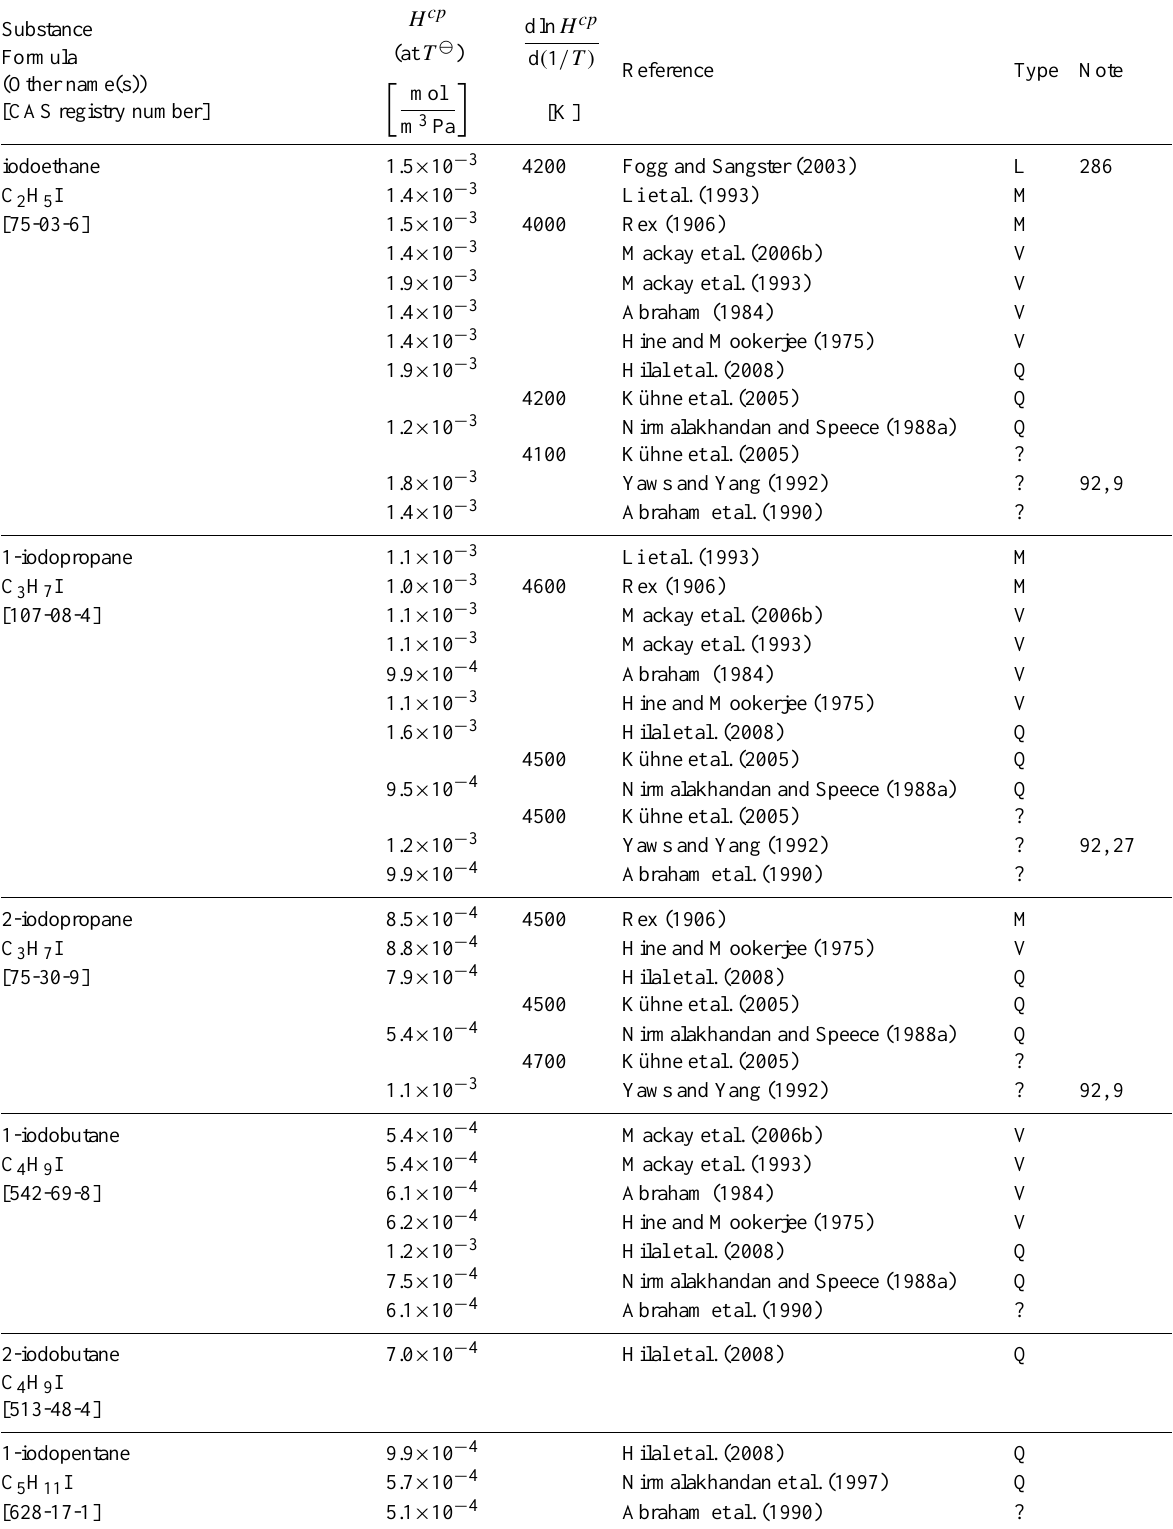
Table 6: Henry’s law constants for water as solvent